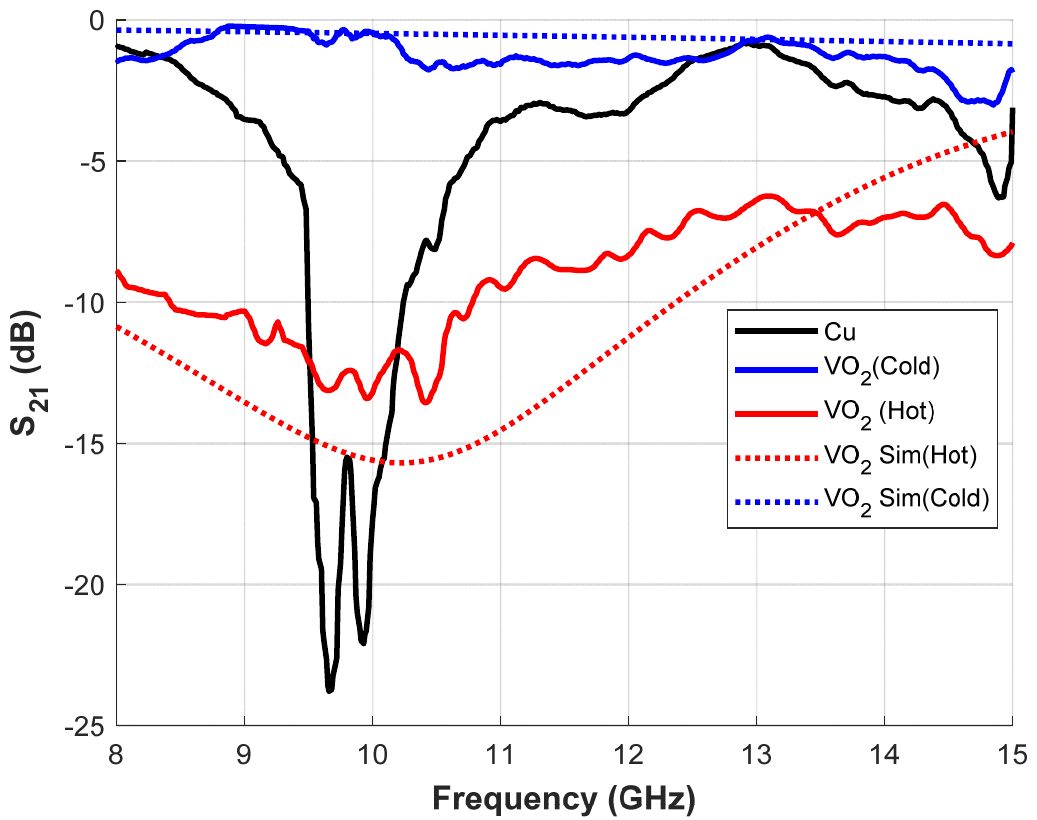
Figure 14. Graph of the measured and simulated transmission coefficient of the FSS dipole array.